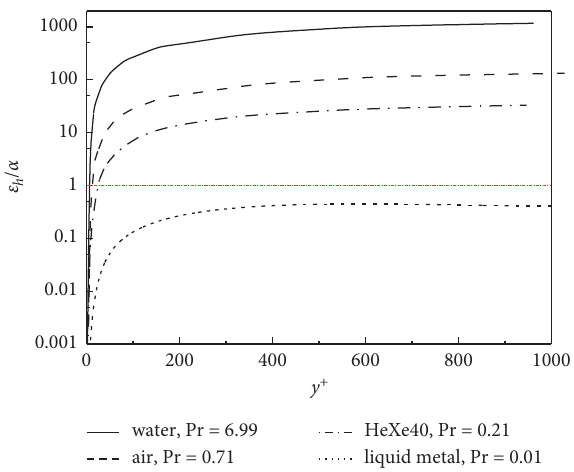
Figure 13: Dimensionless molecular heat conduction ( q + ( q + � q + m + q + t ) of different fluids.